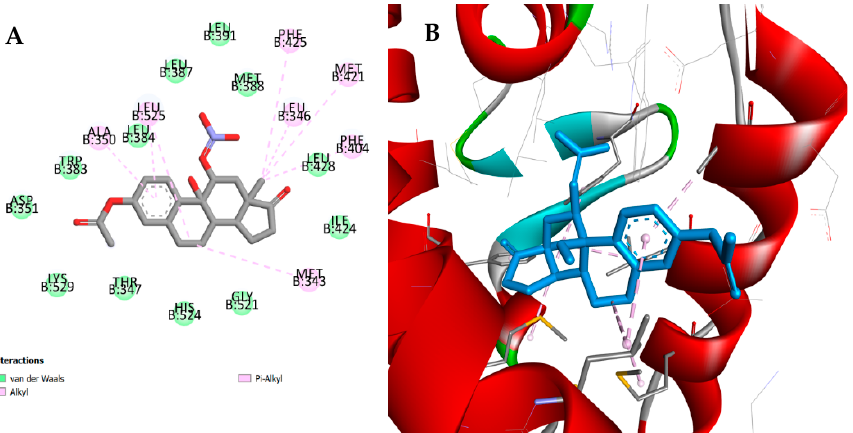
Figure 8. Predicted interactions and binding mode of the best ranked and synthetized compound 5 , with ER α in 2D (panel A) and 3D (panel B). ( A ) Van der Waals interactions are displayed in green, and alkyl and pi-alkyl interactions in soft pink. ( B ) Binding mode of compound 5 in active site of ER α . Van der Waals interactions are displayed in green, and alkyl and pi-alkyl interactions in soft pink.